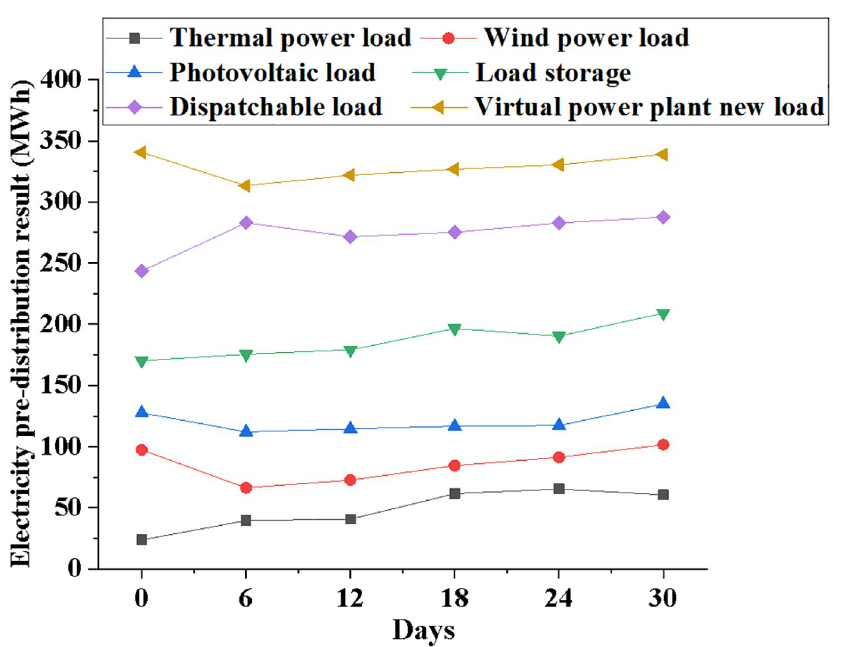
Fig 13. Variation curve of power pre-allocation results of different power load systems with time growth.